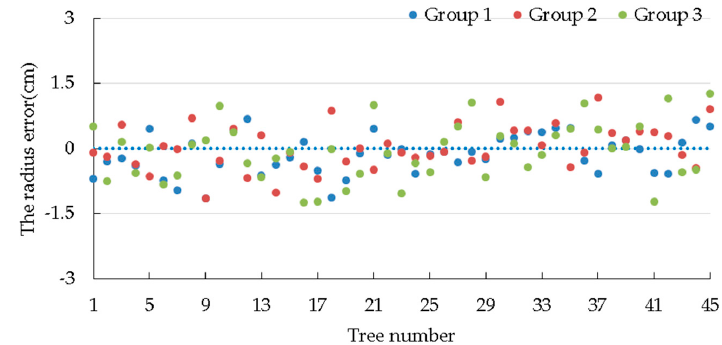
Figure 17. The radius error of the tree.